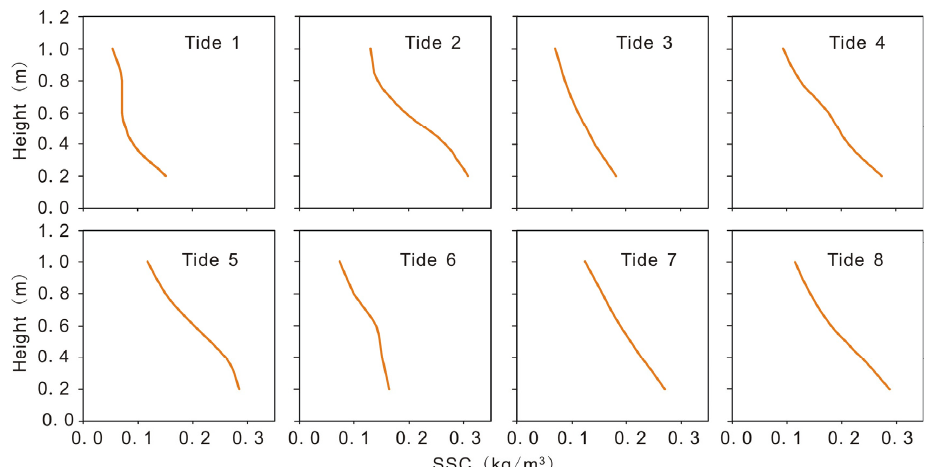
Water 2022 , 14 , x FOR PEER REVIEW Figure 4. Average SSC profile for the same period of inundation. Figure 4. Average SSC profile for the same period of inundation.